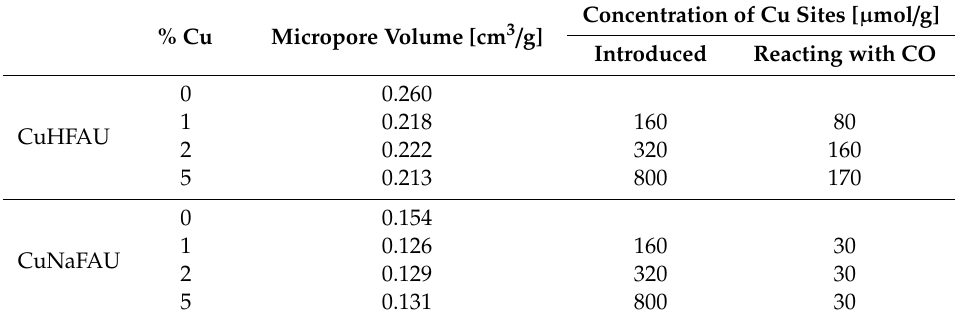
Table 1. Micropore volume and the concentration of Cu sites in zeolites.